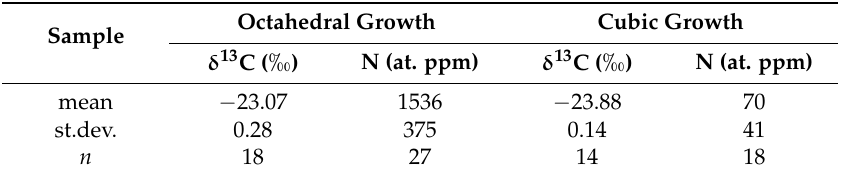
Table 1. Summarized SIMS data of δ 13 C and nitrogen abundances measured within synthetic rims of diamonds grown from carbonate fluid. Statistics account for all the data available for particular crystallography in both 268-1 and 268-1 samples.